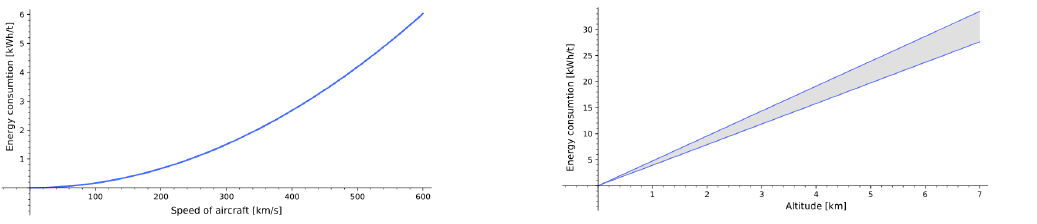
Figure 3. Energy consumption per tonne of aircraft mass required by an aircraft to achieve a specific: ( left ) speed; and ( right ) altitude.